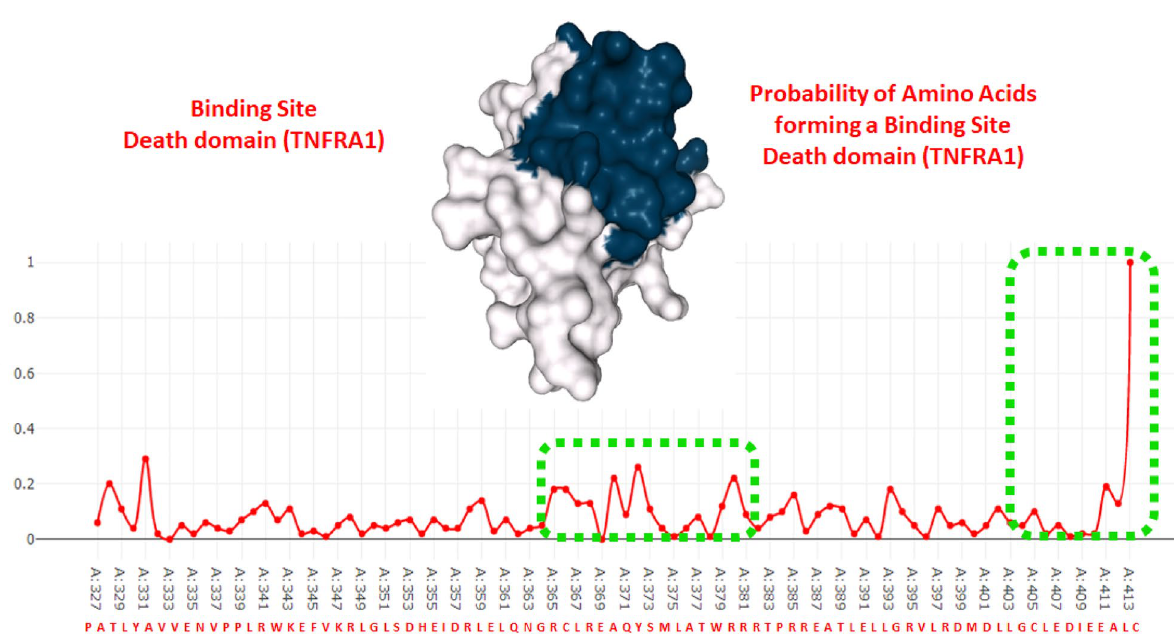
Figure 5. Binding pocket of TNFR1 death domain showing probability of amino acids of forming a binding site Binding interactions of MADD and TNFR1 death